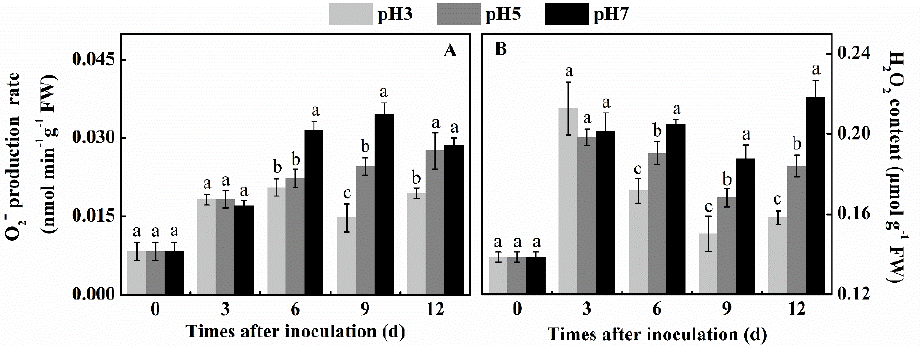
Figure 3. Effect of inoculation of T. roseum at different pH conditions on the O 2 • − production rate ( A ), and H 2 O 2 content ( B ) of colonized apple fruits. Bars indicate standard error (±SE). Different letters indicate statistically significant differences ( p < 0.05) among treatments.